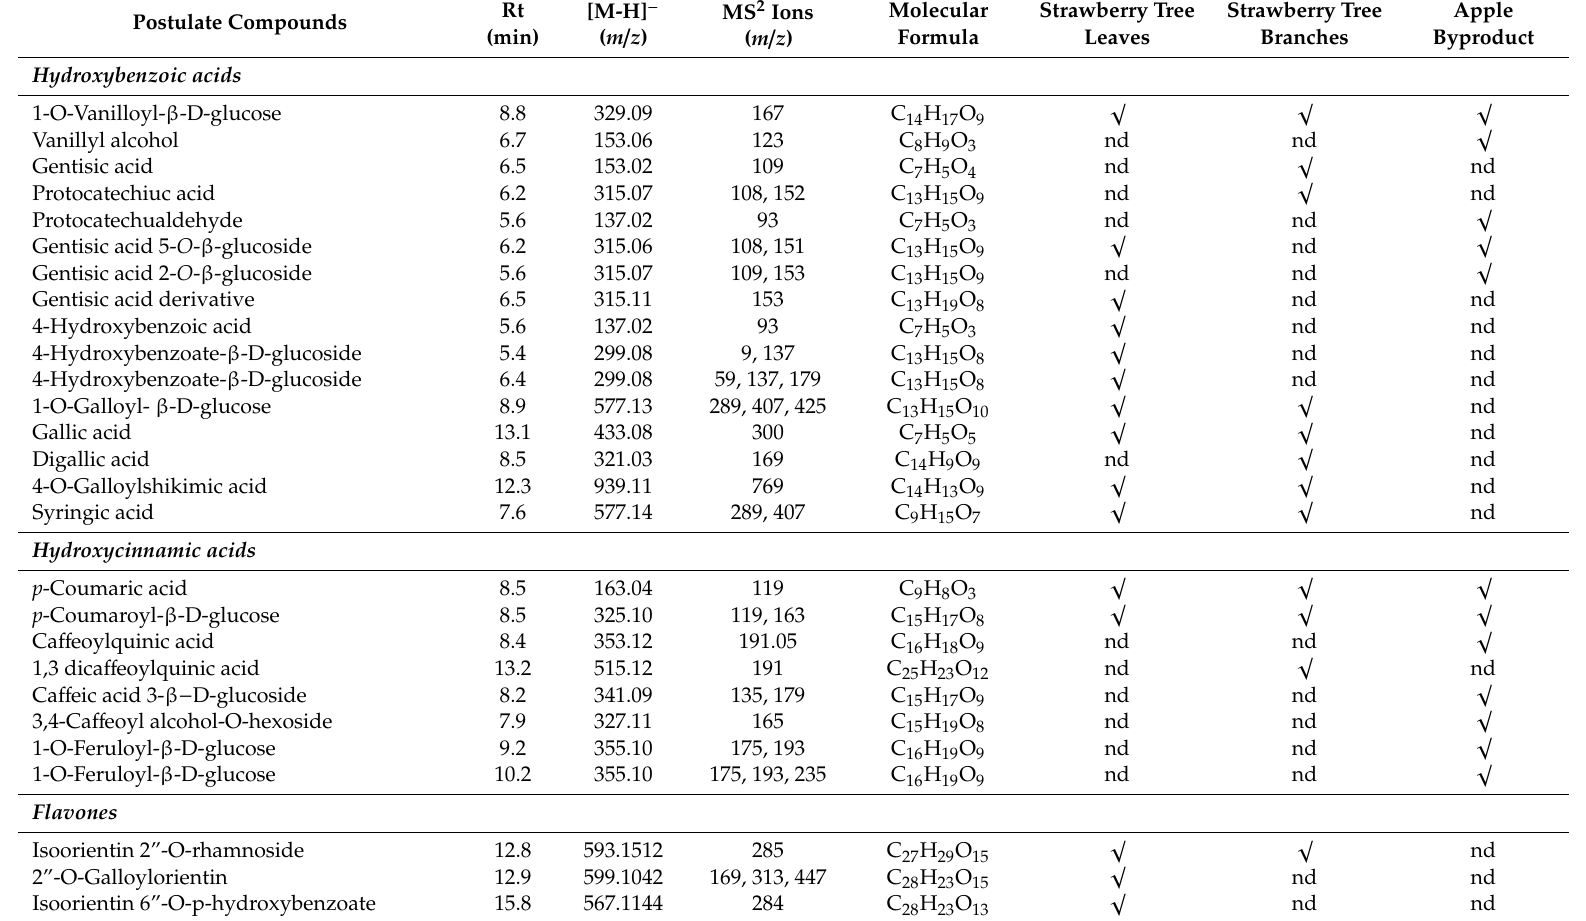
Table 3. LC-ESI-UHR-QqTOF-MS data for phenolic compounds identified in